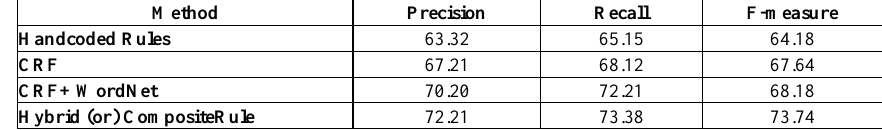
Table 2. Results for Event Extractin MUC DataExample